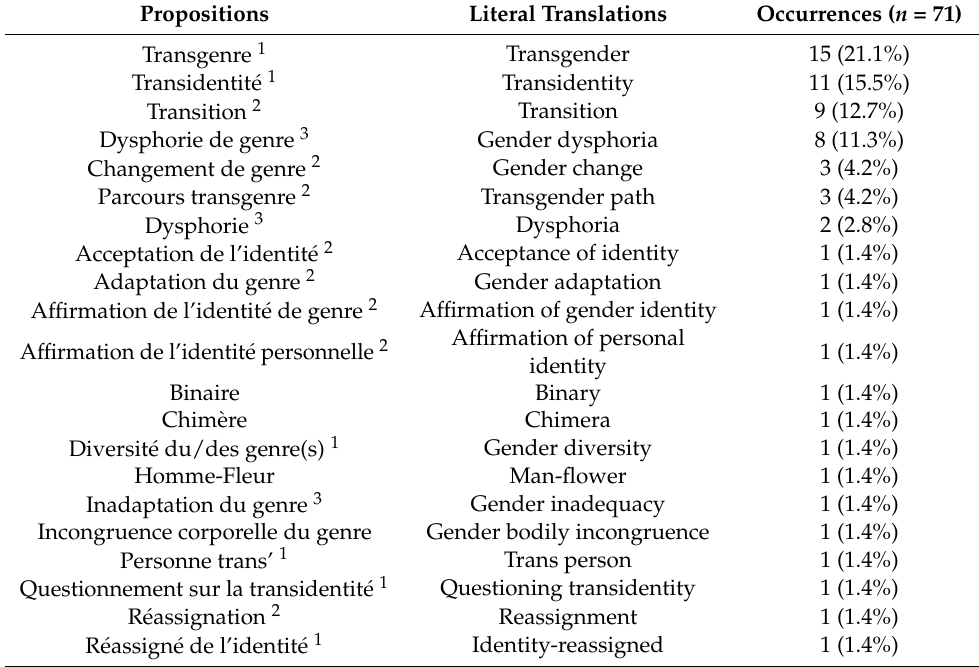
Table 2. Alternative propositions of terms for